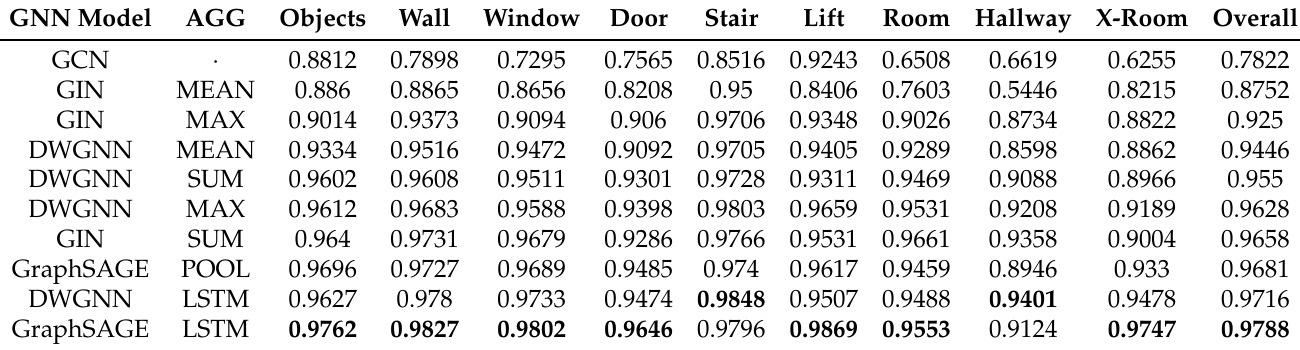
Table 3. Class-wise accuracy comparison on different GNN models on the UOS-aug data